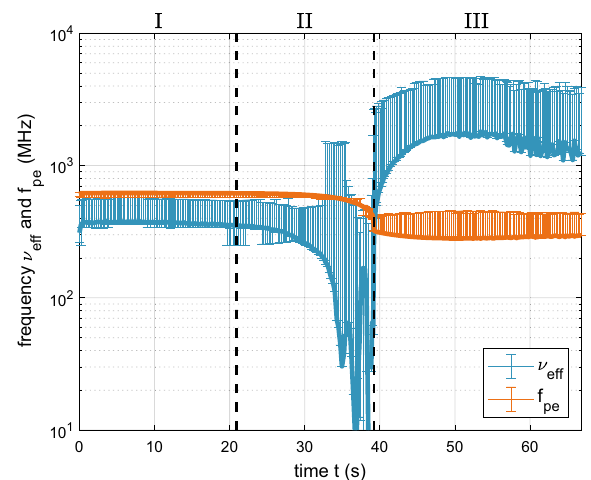
Fig. 1 Characteristic frequencies of the plasma during dust grain formation. The effective collision frequency ν eff (blue line and error bars) and electron plasma frequency f pe (orange line and error bars) are obtained from Microwave Cavity Resonance Spectroscopy measurements as a function of time, with respect to the moment of plasma initiation at t = 0 s, during dust formation in a low-pressure radio-frequency driven capacitively-coupled argon-hexamethyldisiloxane (i.e., HMDSO) discharge. The error bars represent the effect of the (estimated) error in the determination of the resonance frequency and quality factor on the effective collision frequency and electron plasma frequency. The derivation of the error propagation is described in the subsection Microwave Cavity Resonance Spectroscopy in the Methods. The gas discharge was created under the following experimental conditions: partial argon pressure at 5.7 × 10 − 2 mbar (43 mTorr), partial HMDSO pressure at 1.4 × 10 − 2 mbar (11 mTorr), plasma volume of 42 cm 3 (2.56 in 3 ), and absorbed power density of 0.7 W cm − 3 (11.7 W in -3